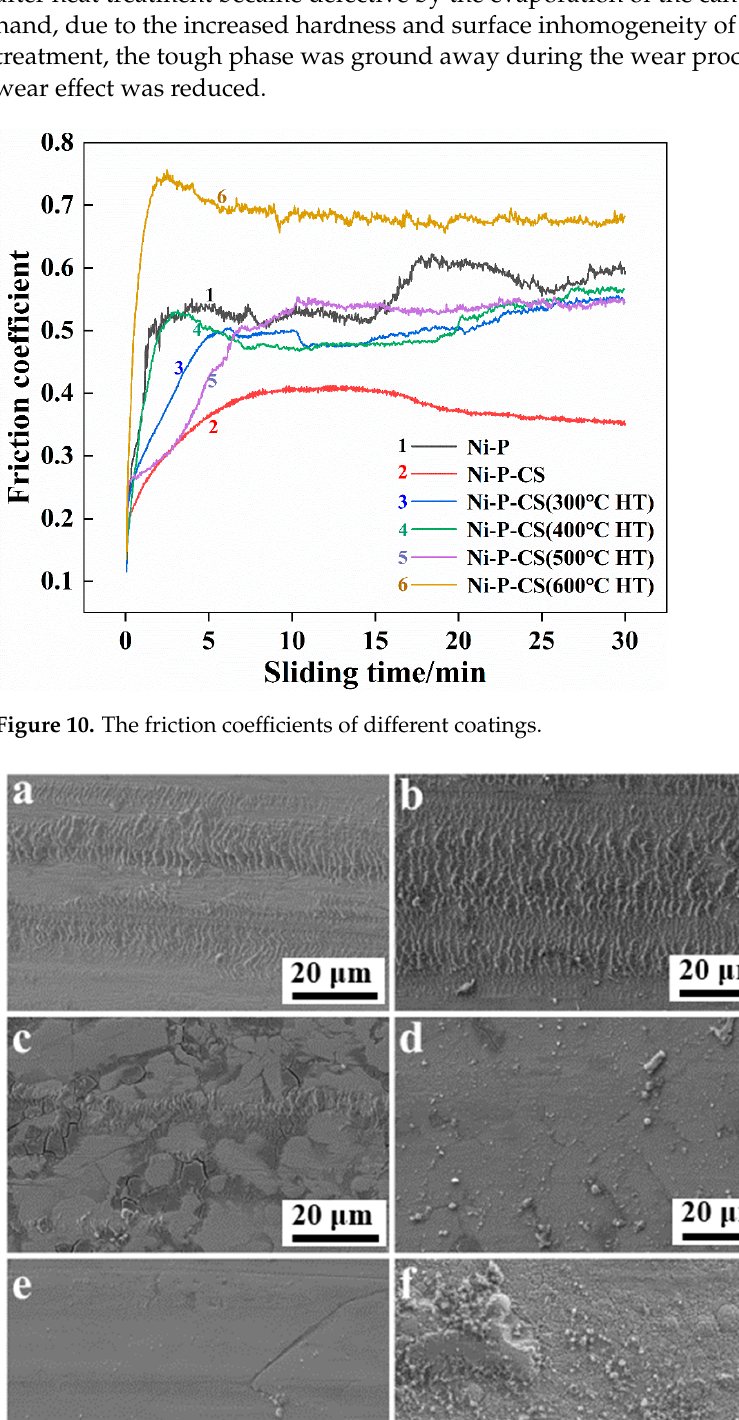
Figure 9. Surface morphology of the Ni-P-CS coating after heat treatment at different tempera- tures. ( a ) 300 °C Heat Treatment, ( b ) 400 °C Heat Treatment, ( c ) 500 °C Heat Treatment, ( d )600 °C